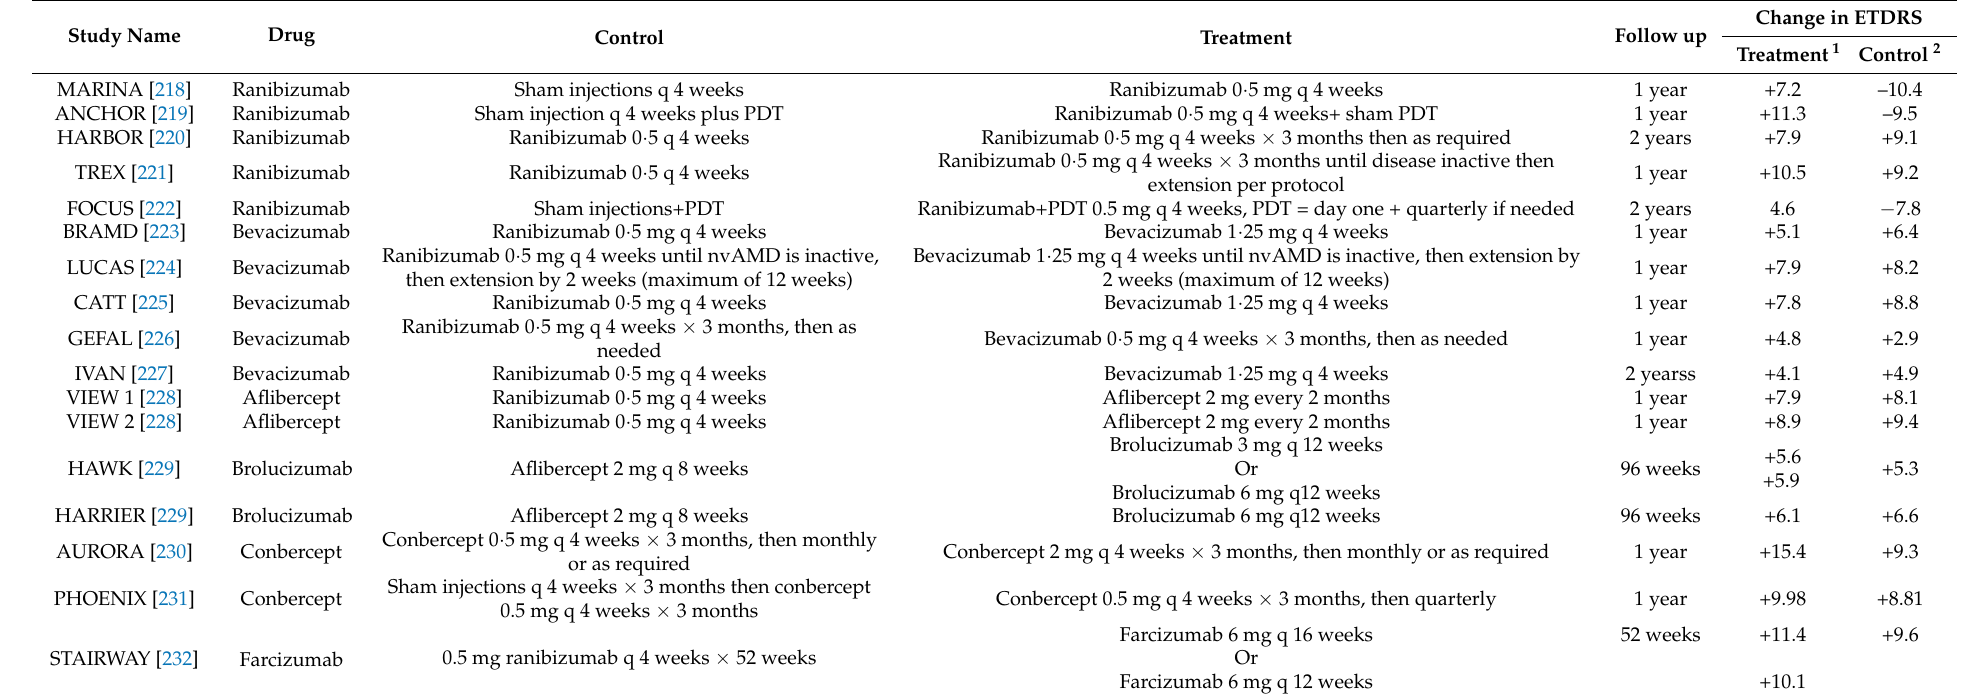
Table 5. Anti-vascular endothelial growth factor (Anti-VEGF) clinical